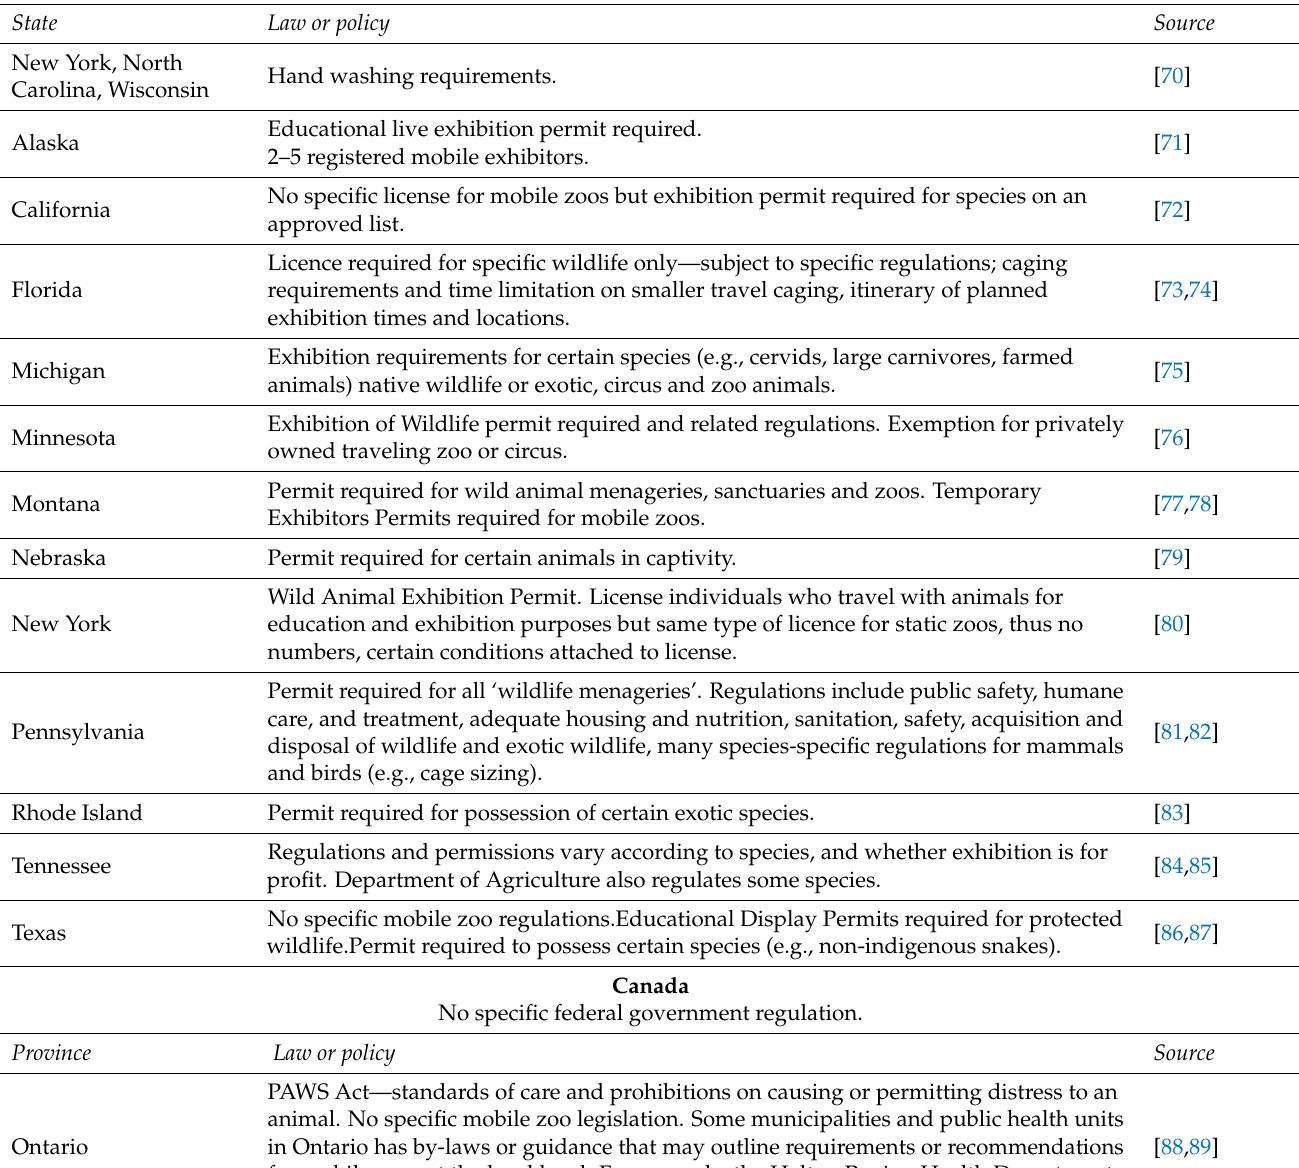
United States of